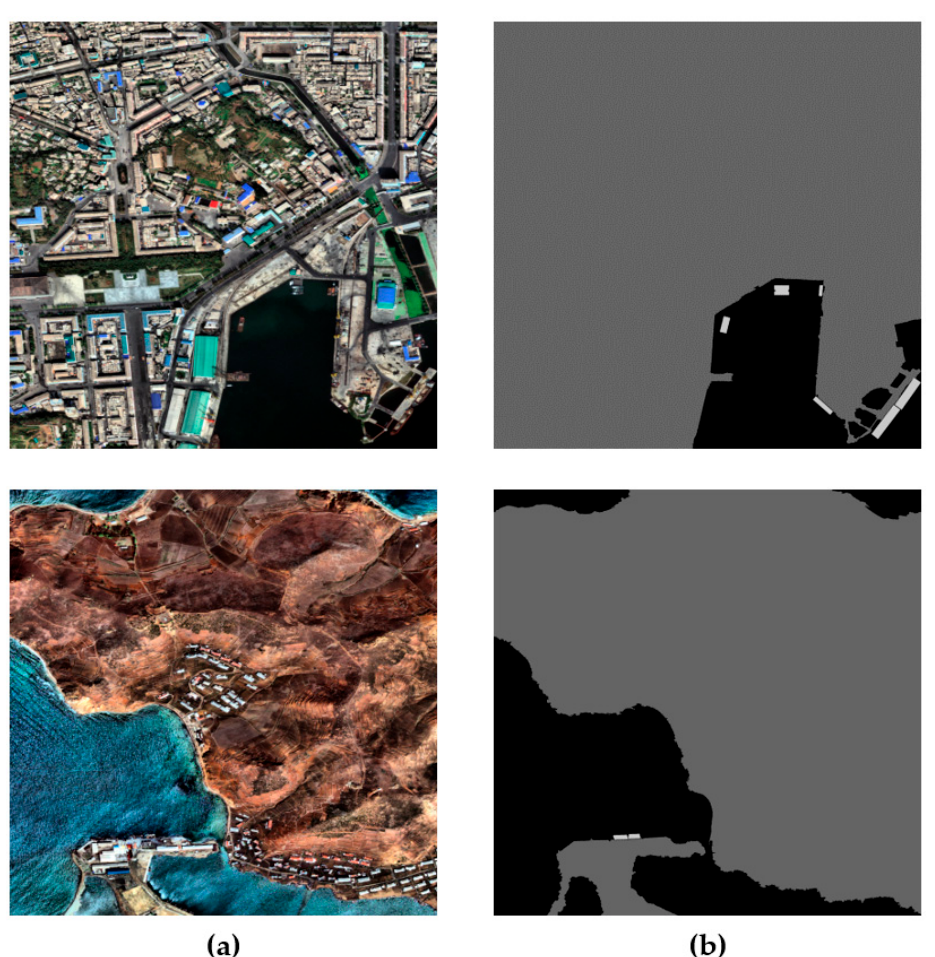
Figure 8. EO satellite image and segmentation mask image samples of the SDS dataset. ( a ) EO satellite image; ( b ) segmentation annotation mask image.